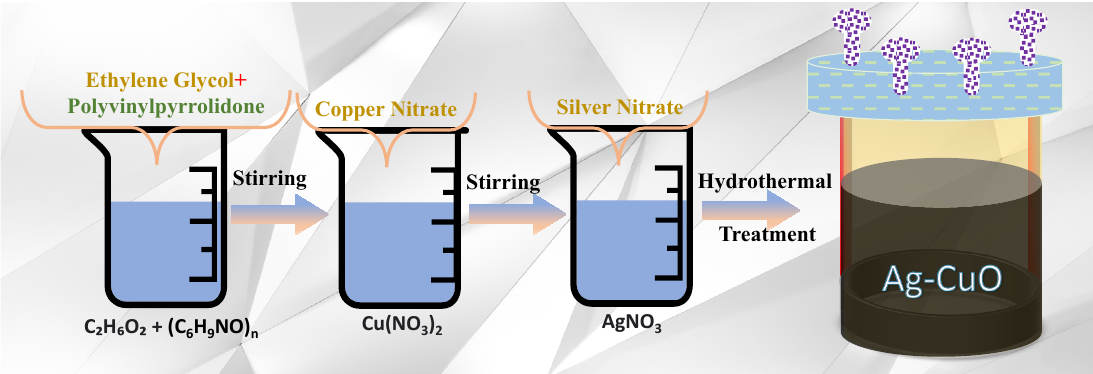
Figure 1. Systematic steps involved in the synthesis of the Ag-CuO nanohybrids.